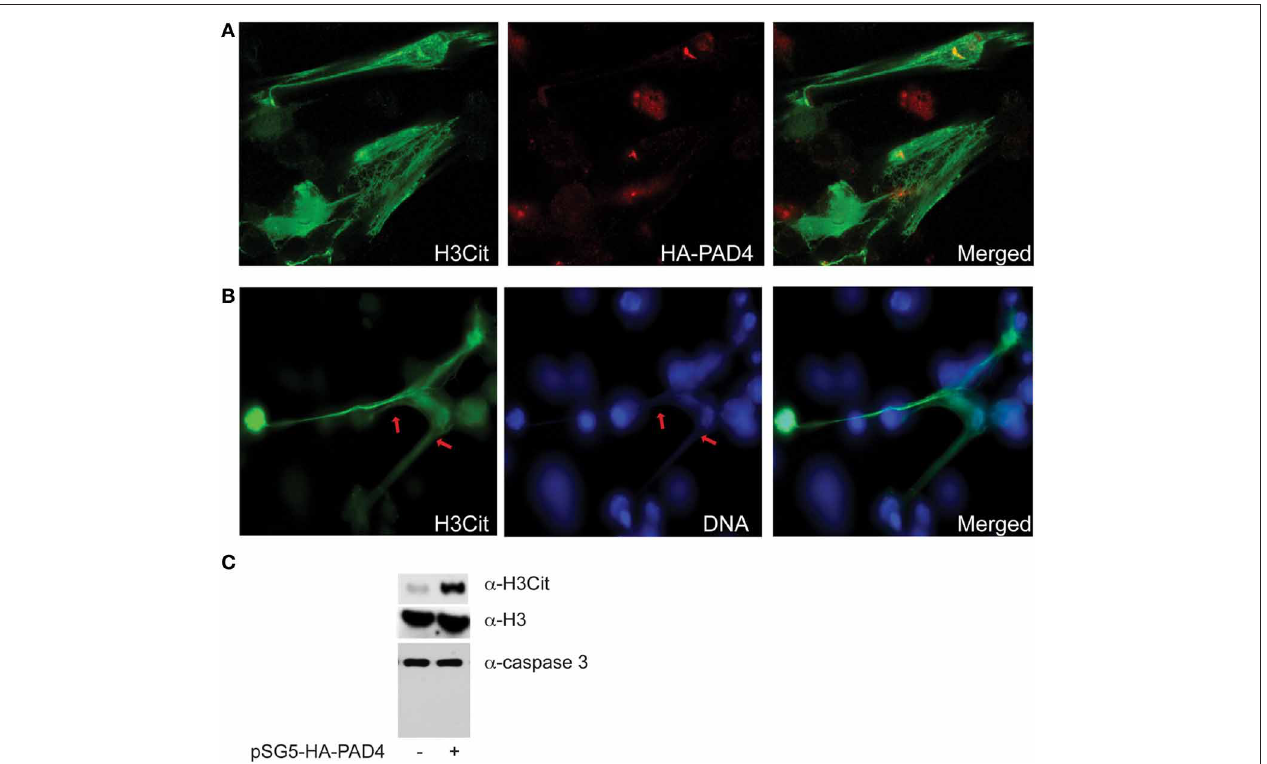
FIGURE 1 | Dramatic chromatin decondensation and formation of NET-like structures upon forced PAD4 expression. (A) Immunostaining of U2OS cells with the H3Cit and the HA antibodies after forced HA-PAD4 expression by transient transfection. Note the dramatic global histone H3 hypercitrullination. (B) Immunostaining of H3Cit and DNA staining showing